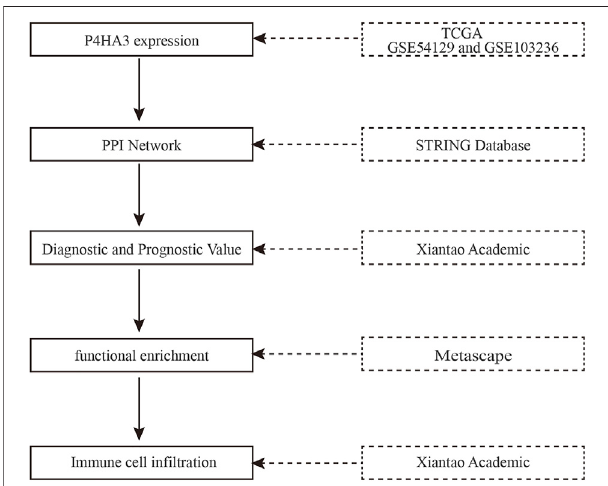
FIGURE 1 | The fl owchart of the present study.